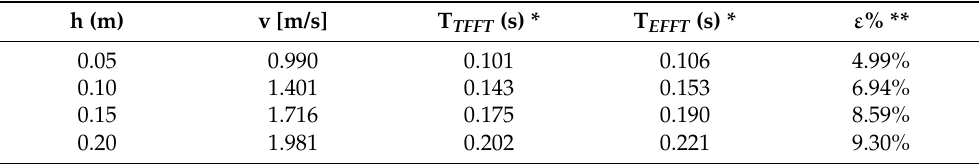
Table 2. Impact velocities and free fall